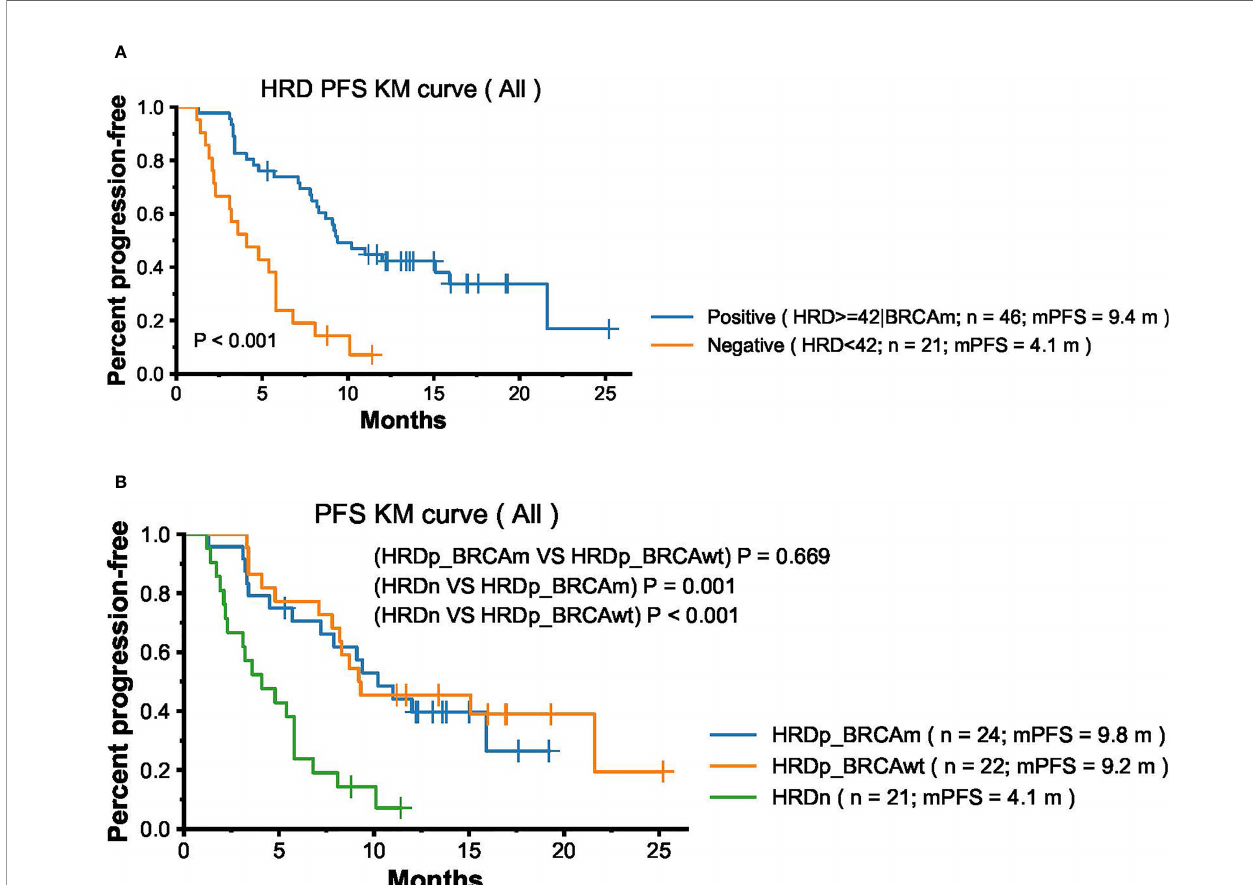
FIGURE 2 | Association Between HRD status and PFS in Ovarian Cancer Patients treated with PARPi olaparib and niraparib. (A) Progression-free survival (PFS) by HRD status positive (N = 46) and negative (N = 21). (B) Progression-free survival (PFS) by three group: BRCA mutation HRD positive group (N = 24), BRCA wildtype HRD positive (N = 22), and HRD negative (N =